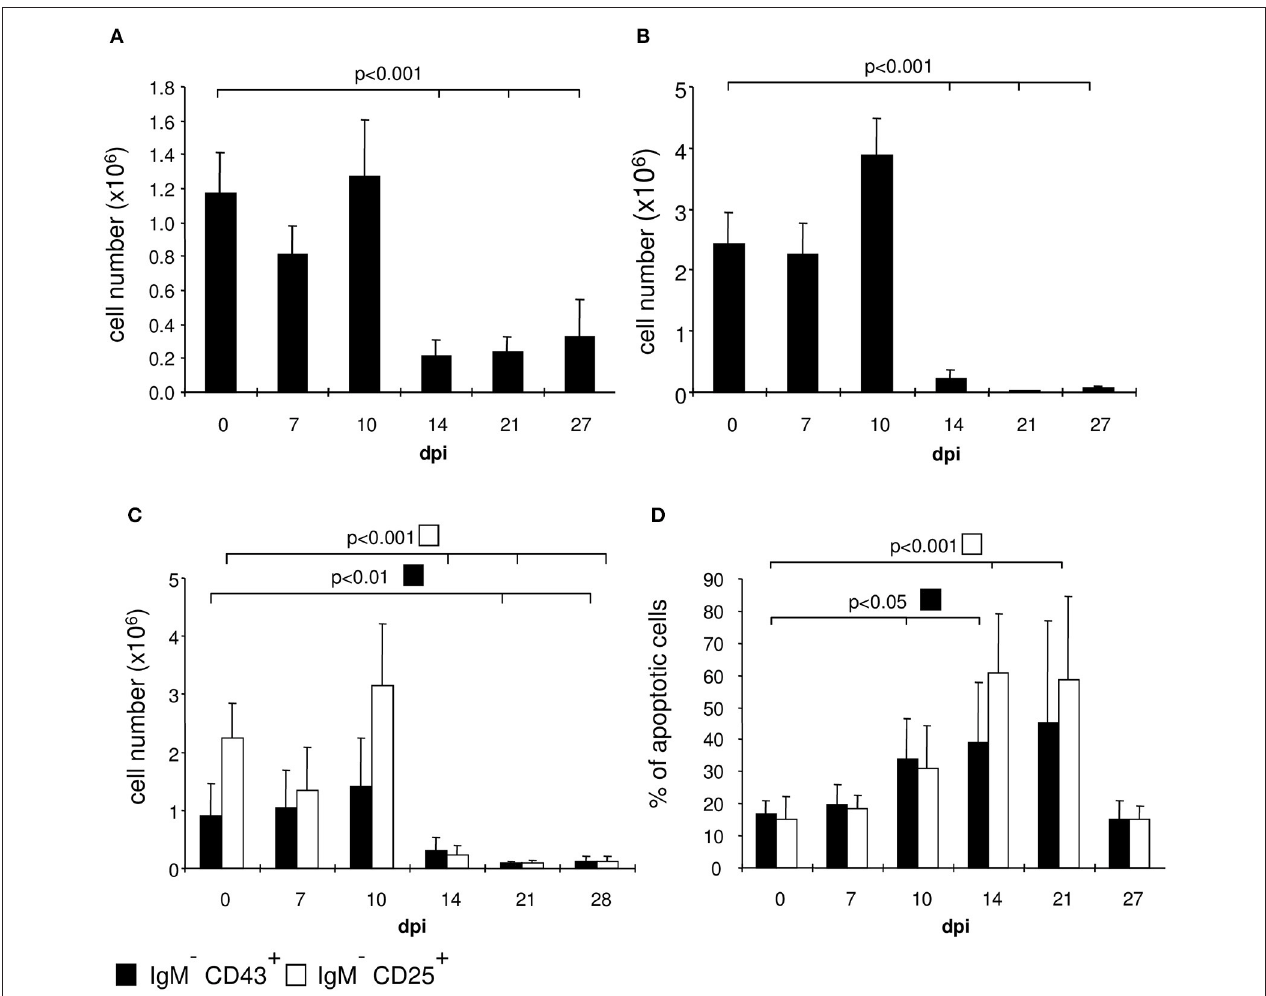
FIGURE 4 | T. cruzi infection induces apoptosis of pro- and pre-B cells. C57BL/6 mice were infected with 75 T. cruzi blood trypomastigotes i.p. (infections with 500 T. cruzi blood trypomastigotes show comparable results). At the indicated time points we calculated the absolute numbers of (A) IgM + B cells, (B) IgM − precursors, and (C) the absolute numbers and (D) proportion of apoptotic CD43 + pro- and CD25 + pre-B cells. Data represent the mean ± SD of pooled results from three independent experiments each comprising 5 mice per time point. Statistical analysis was performed using two-tailed Student’s t -test.